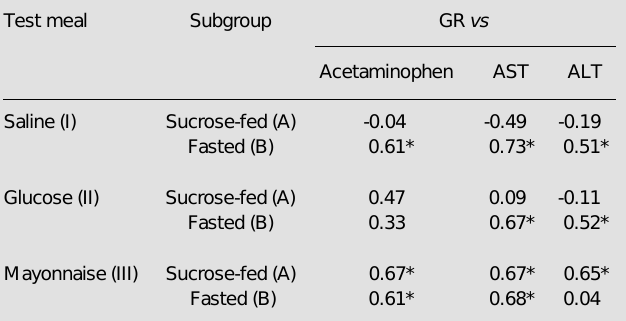
Table 2 - Correlation (rs) between gastric retention (GR) and serum levels of acetaminophen, aspartate aminotransferase (AST) and alanine ami- notransferase (ALT) in rats following different test